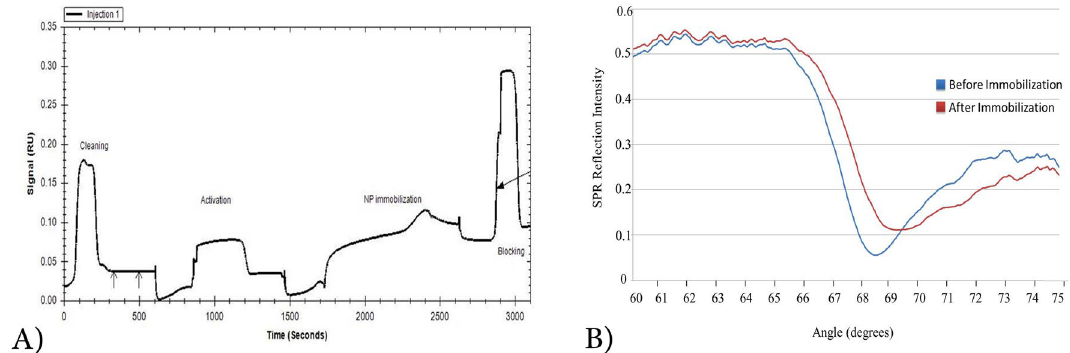
Figure 3. Biotin immobilization of NP on a pre-coated streptavidin chip. ( A ) Signal change during injection, (B) angle shift before and after stabilization.